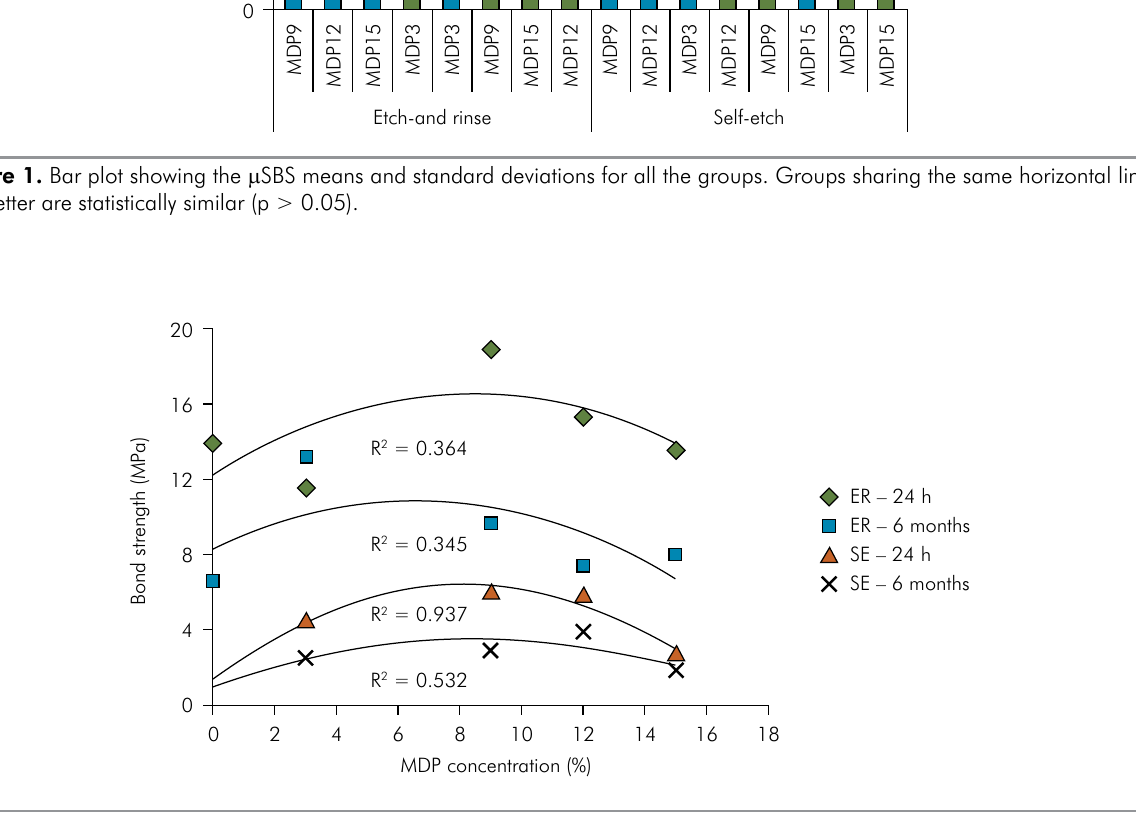
Figure 2. Correlation between bond strength (24 hours and 6 months) and MDP concentration for the experimental adhesives, according to the application